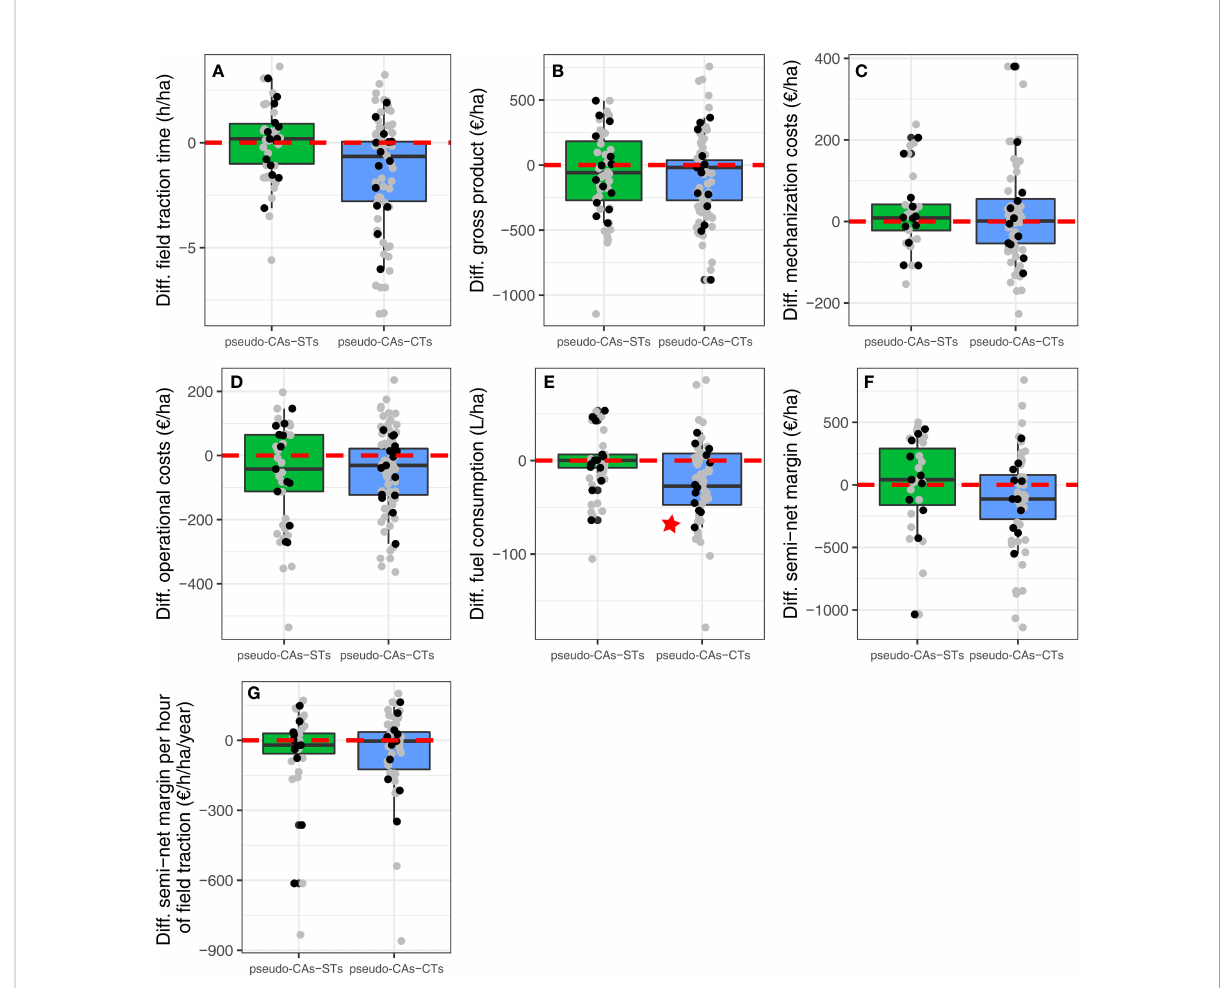
FIGURE 7 Technical and economic performances of pseudo-conservation agriculture systems (pseudo-CAs). Distributions of the differences in response variables between pseudo-CAs and their reference conventional tillage (CTs, blue boxplots) and super fi cial tillage (STs, green boxplots) based systems for mechanized work time (h/ha/year, A ), gross product ( € /ha/year, B ), mechanization costs ( € /ha/year, C ), operating costs ( € /ha/year, D ), fuel consumption (L/ha/year, E ), semi-net margin ( € /ha/year, F ) and semi-net margin per hour of fi eld traction ( € /h/ha/year, G ). Grey dots represent individual differences between systems. Black dots represent average differences per cluster. Red stars indicate signi fi cant differences between pseudo-CA and its reference system (either CTs or STs) at p<0.05. Clusters were accounted for as random effects in the model, cluster accounting for the production situation included as a random effect in the model (see details in Table